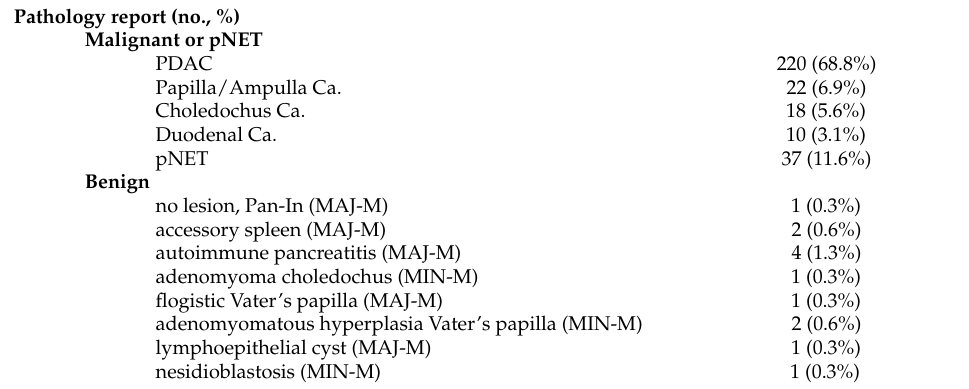
Table 3. Pathology ( n =